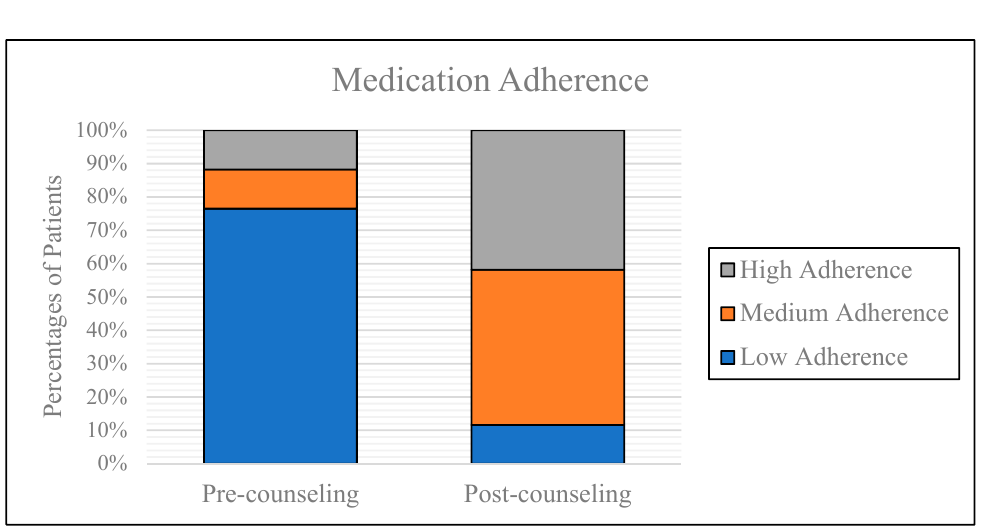
Figure 2. Comparison of pre ‐ and post ‐ counseling medication adherence in the intervention group.